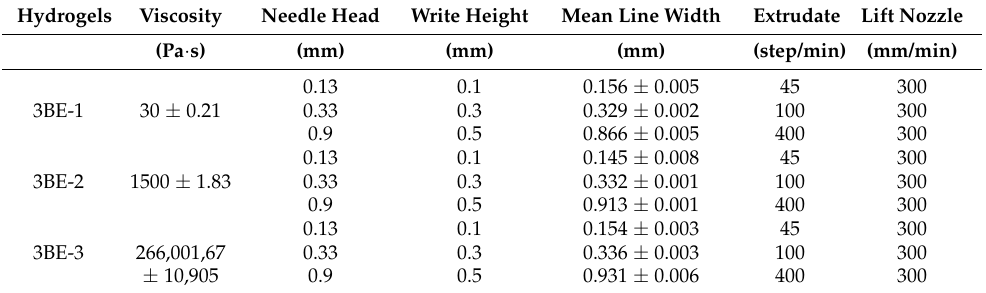
Table 1. Printing parameters of 3BE using self-fabricated 3D bioprinting